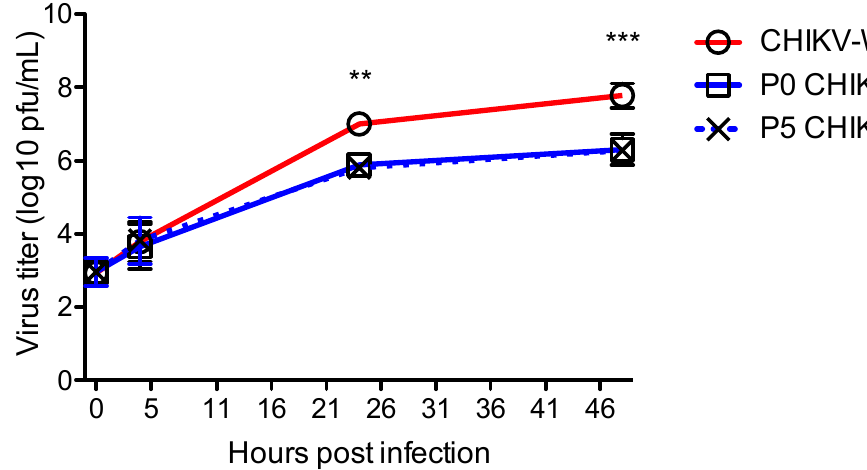
Figure 3. Multistep growth kinetics of CHIKV-NoLS in C6/36 cells after extended in vitro passage. C6/36 cells were infected with CHIKV-WT, P0 CHIKV-NoLS or P5 CHIKV-NoLS at an MOI of 0.1 PFU/cell. Supernatants were collected at the indicated time points, and infectious virus was quantified by plaque assay. **, p < 0.01, and ***, p < 0.001. Statistical analyses were performed using two-way ANOVA with Bonferroni post-tests. Each symbol represents the mean ± standard error from 3 independent experiments.